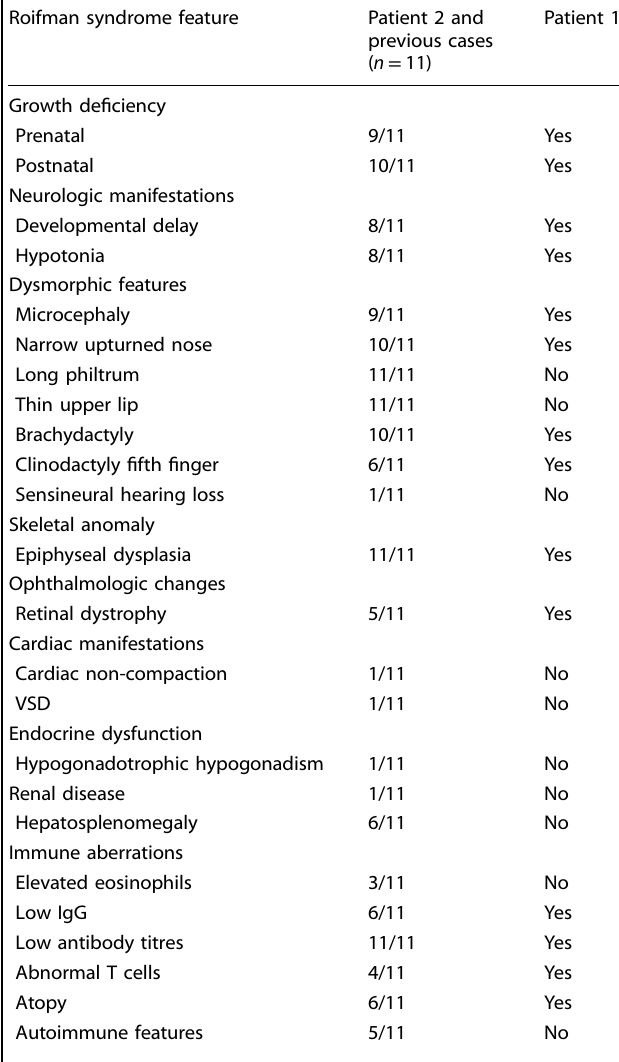
Table 1. Patients ’ clinical characteristics Roifman syndrome